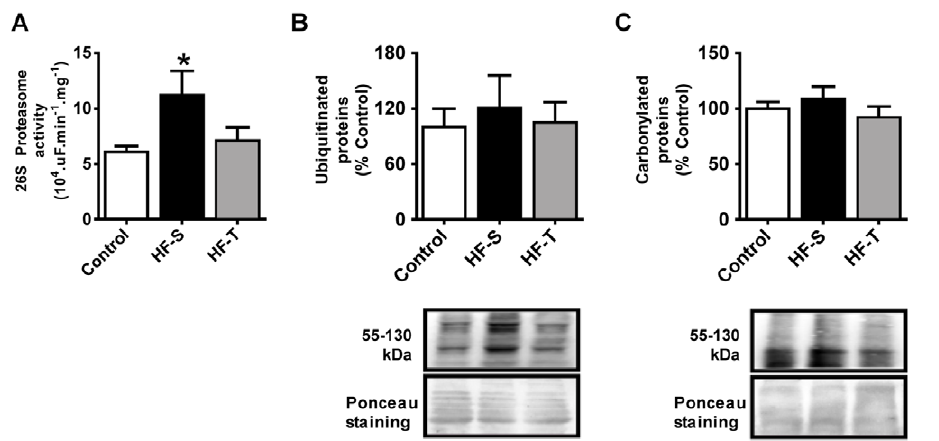
Figure 6. Skeletal muscle UPS in human HF. Chymotrypsin-like proteasome activity (A) and protein ubiquitination (B) and carbonylation (C) in healthy control subjects (Control), sedentary (HF-S) and trained HF (HF-T) patients. Immunobloting data are shown as percentage of Control group (set to 100%). Data are presented as mean 6 standard error from mean. *p , 0.05 vs. Control.